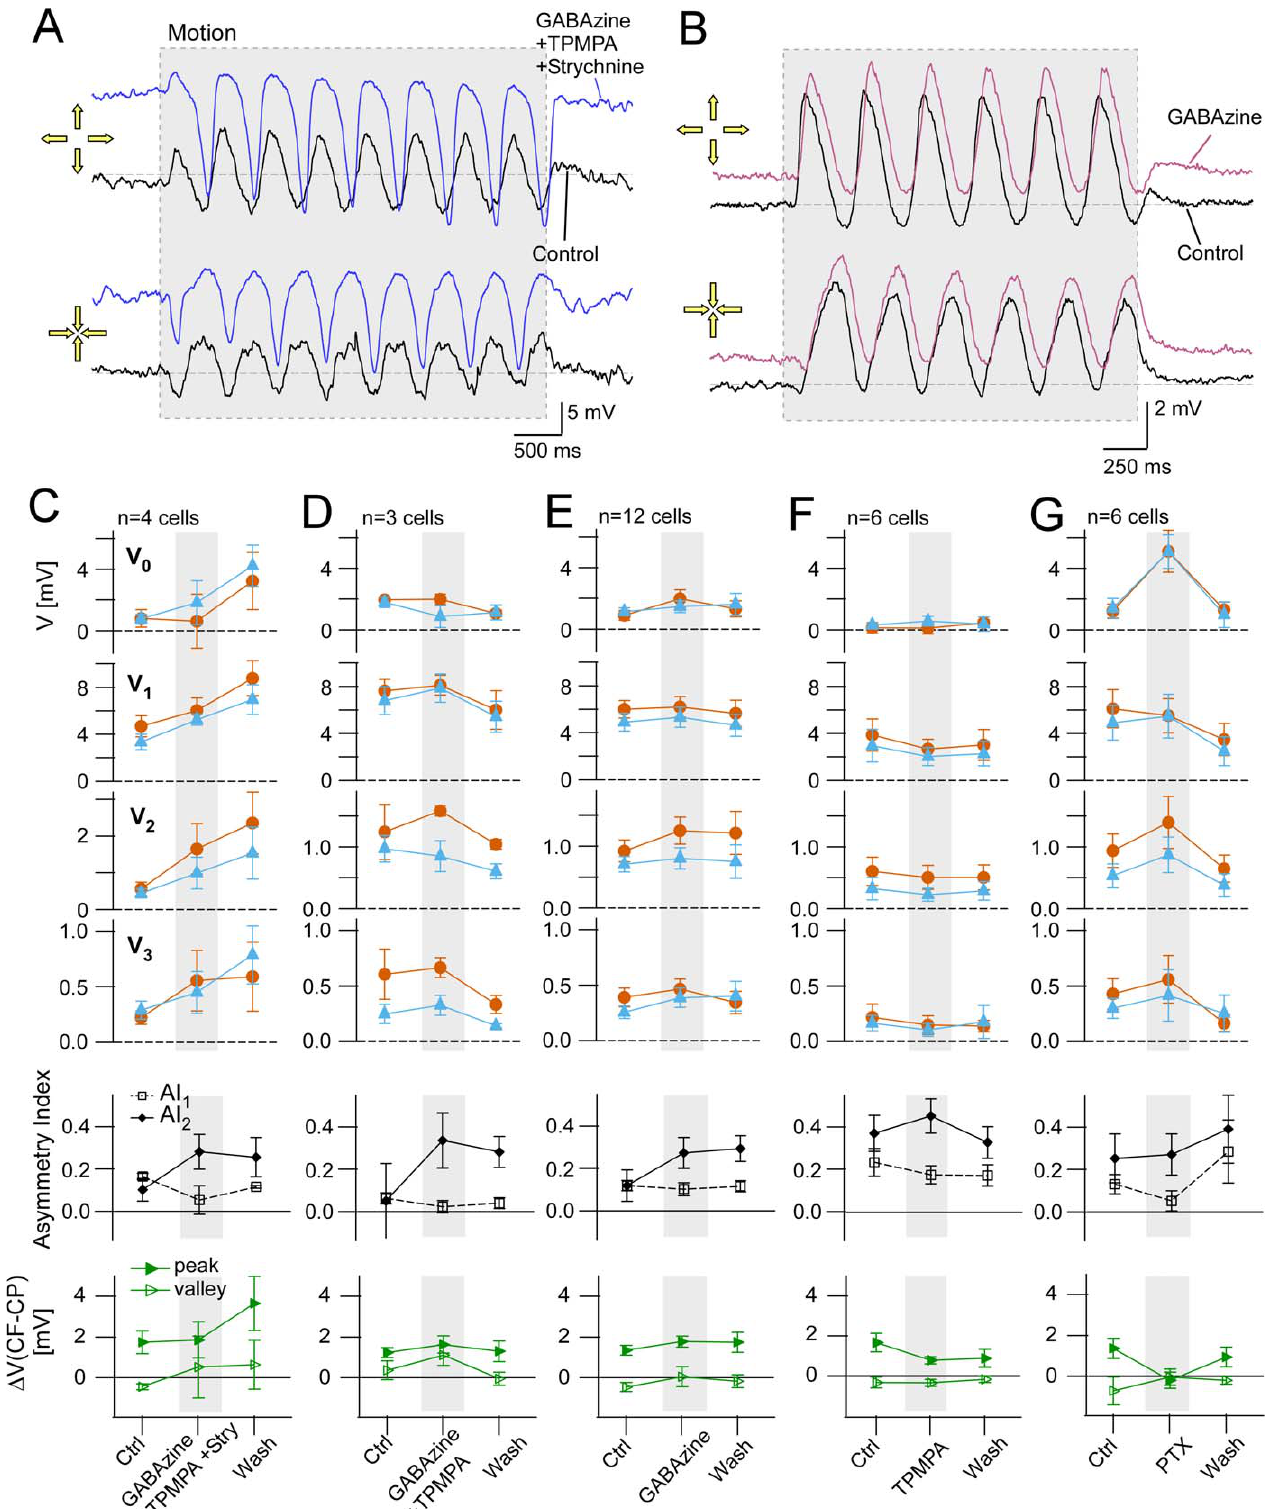
Figure 4. Effects of GABA Receptor Antagonists (A and B) Voltage responses to circular wave stimuli recorded before (control, black; V Rest [A] (cid:2) 62 mV, [B] (cid:2) 49 mV) and during bath application of a mixture of GABA A , GABA C , and glycine receptor antagonists ([A] blue traces; Gbz þ TPMPA þ strychnine; V Rest ¼(cid:2) 53 mV) and Gbz alone ([B] purple traces; V Rest ¼(cid:2) 48 mV). Traces (averages of three trials) overlaid to facilitate comparison; the vertical shifts reflect drug-induced changes in V Rest ; (A) and (B) show different cells. Gray area indicates motion duration. (C–G) Top row: averaged amplitudes of DC ( V 0 ) , the fundamental ( V 1 ), and the harmonics ( V 2 and V 3 ) for different GABA/glycine receptor antagonists and mixtures thereof (25–50 l M Gbz, 50–75 l M TPMPA, 300 l M PTX, 1 l M strychnine; CF motion: orange circles; CP motion: blue triangles; gray box: PLoS Biology |